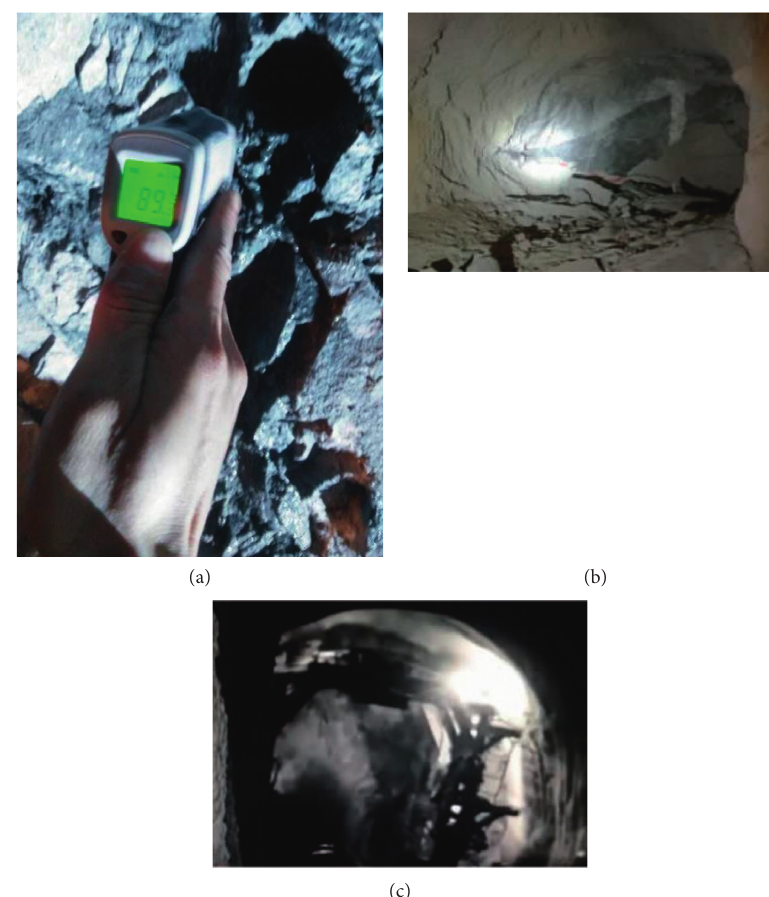
Figure 1: Rock temperature and rockburst disasters in the Sangzhuling tunnel: (a) on-site rock temperature test photo [14]; (b) rockburst photo of tunnel arch foot [16]; (c) instant rockburst photo of tunnel vault